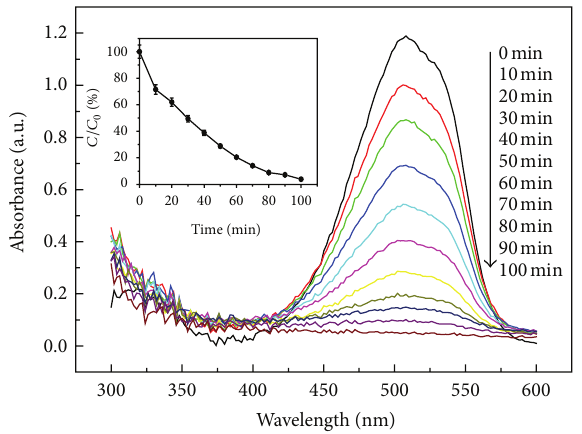
Figure 7: Absorption spectra of the solution of MO exposed to irradiation for different time (inset is degradation of MO under visible-light